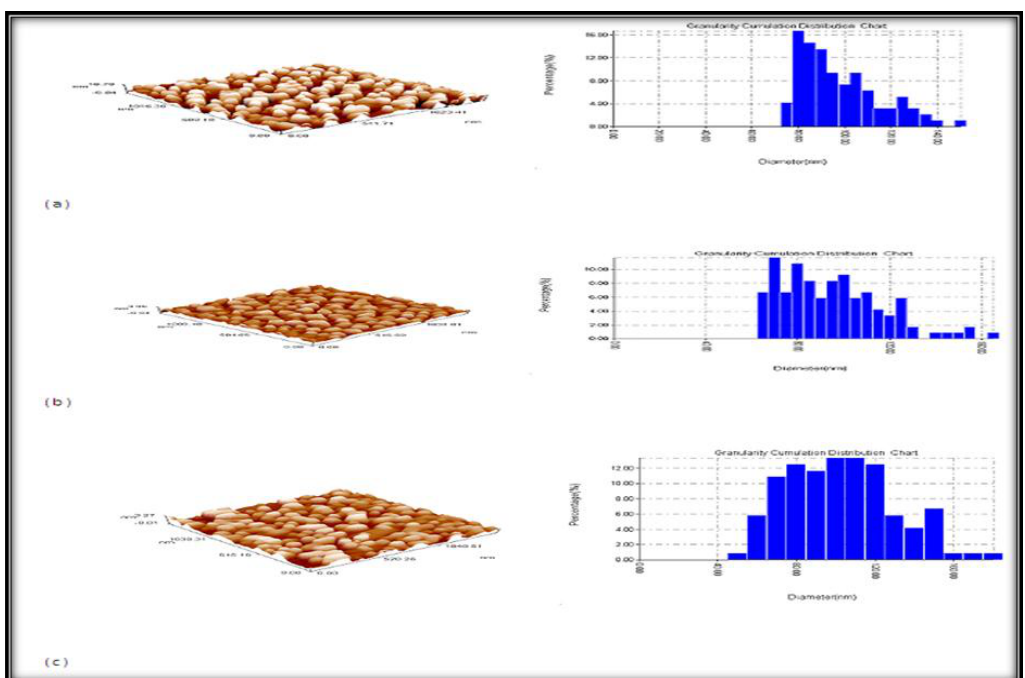
Cu O films deposited at room temperature 2 2 4 Root mean Grain square(nm)